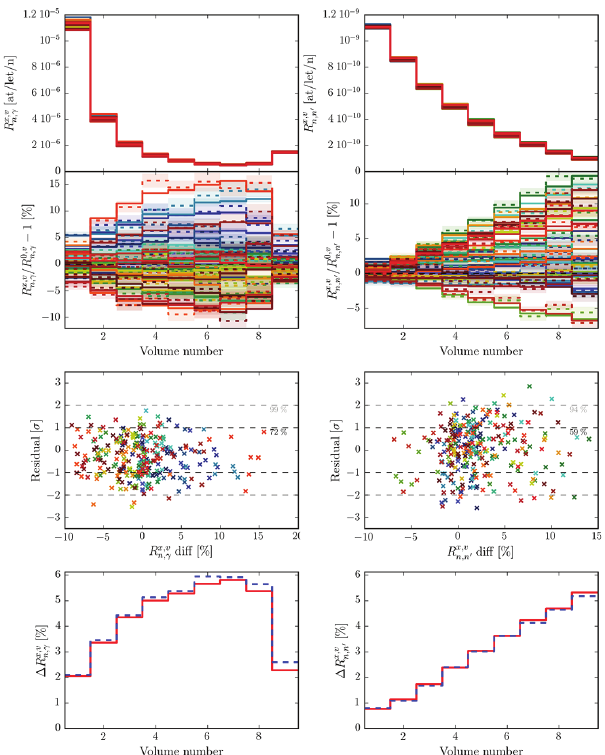
Fig. 12. Reaction rate distribution (top) for capture (left) and inelastic (right) reactions, relative variation (second line) with the reference in dashed line, residuals (third line) and reaction rate dispersion